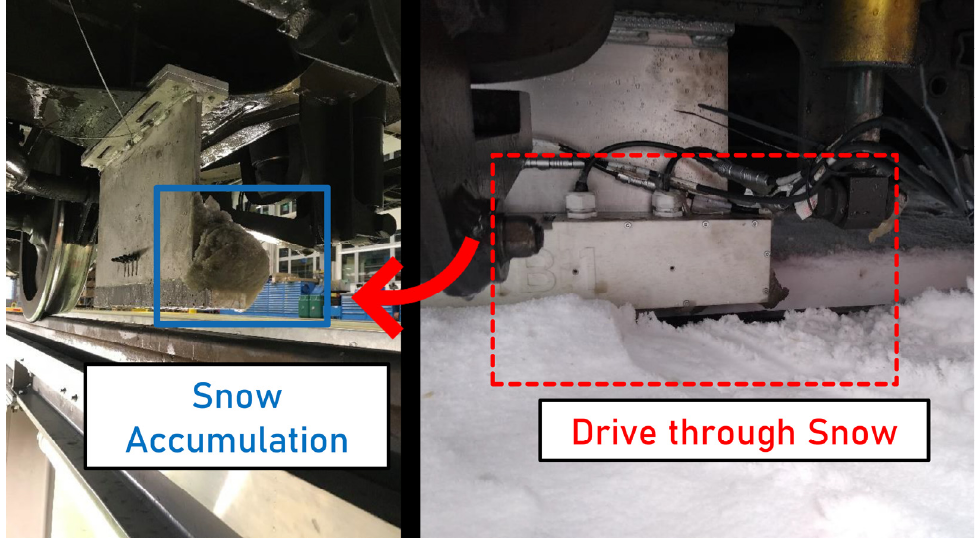
Figure 9. Snow accumulation at the measuring box and driving in snow (snow cover thickness approx. 50 cm ).